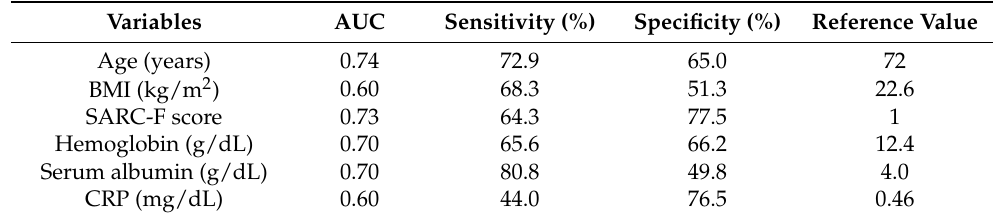
Table 4. Receiver operating characteristic curve analysis of independent factors in the multivariate analysis for the grip strength